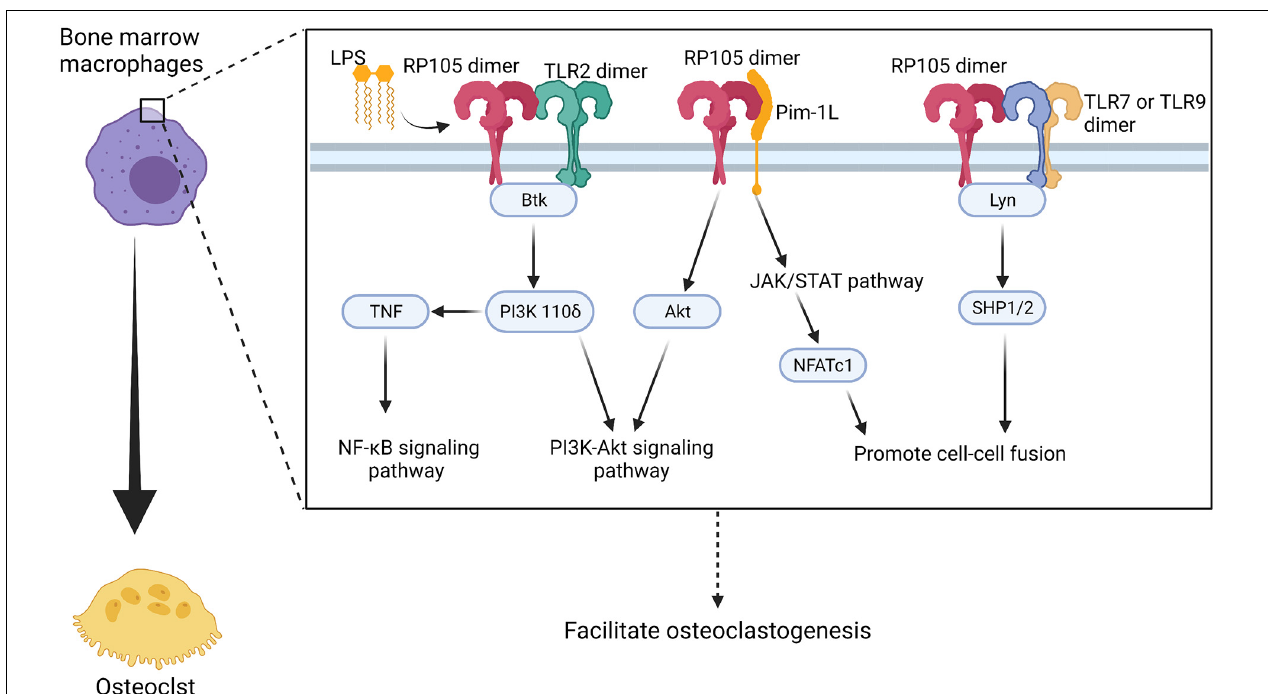
FIGURE 5 | Potential regulatory manner of RP105 in activating osteoclastogenesis of bone marrow macrophages. RP105 promotes the differentiation of bone marrow macrophages into osteoclasts with different “signaling-competent” partners. As a result, there’re three potentially regulate manner of RP105 in the differentiation process: (1) TLR2 works as a “signaling-competent” of RP105 (Carreras-Gonzalez et al., 2018) and forms RP105/TLR2/Btk axis to up-regulate PI3K p110 δ to activate the PI3K-Akt as well as promotes production of TNF and activation of NF- κ B pathways (Blumenthal et al., 2009; Yu et al., 2015); (2) Pim-1L works another “signaling-competent” of RP105 (Egli et al., 2015) and stimulate expression of NFATc1 through JAK/STAT pathway (Kim et al., 2010) and activate Akt to promote PI3K-Akt signaling pathway (Hu et al., 2009); (3) RP105 also could inhibit TLR7 and TLR9 signaling and the downstream Lyn/SHP-1/2 manner, which activate Ca 2 + signaling pathway and promote cell-cell fusion (Yang et al., 2018a). Figure was created using